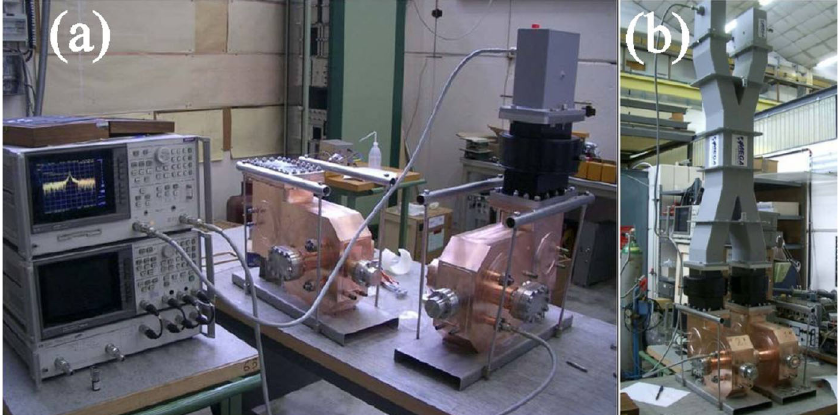
FIG. 9. (Color) (a) Two rf deflecting cavities on the test bench, the cavities are made of OFHC copper. (b) Assembled cavities with HJ, ceramic window, and waveguides.